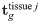
MultiXcan method.Panel a illustrates the MultiXcan method. Predicted expression from all available tissue models are used as explanatory variables. To avoid multicolinearity, we use the first k Principal Components of the predicted expression. y is a vector of phenotypes for n individuals, tgtissuej is the standardized predicted gene expression for tissue j, gj is its effect size, a is an intercept and e is an error term. Panel b shows a schematic representation of MultiXcan results compared to classical PrediXcan, both for a single relevant tissue and all available tissues in agnostic scanning. y is a (centered) vector of phenotypes for n individuals, tj is the standardized predicted gene expression for model j, gj is its effect size in the joint regression, γj is its effect size in the marginal regression using only prediction j, e and ϵj are error terms.